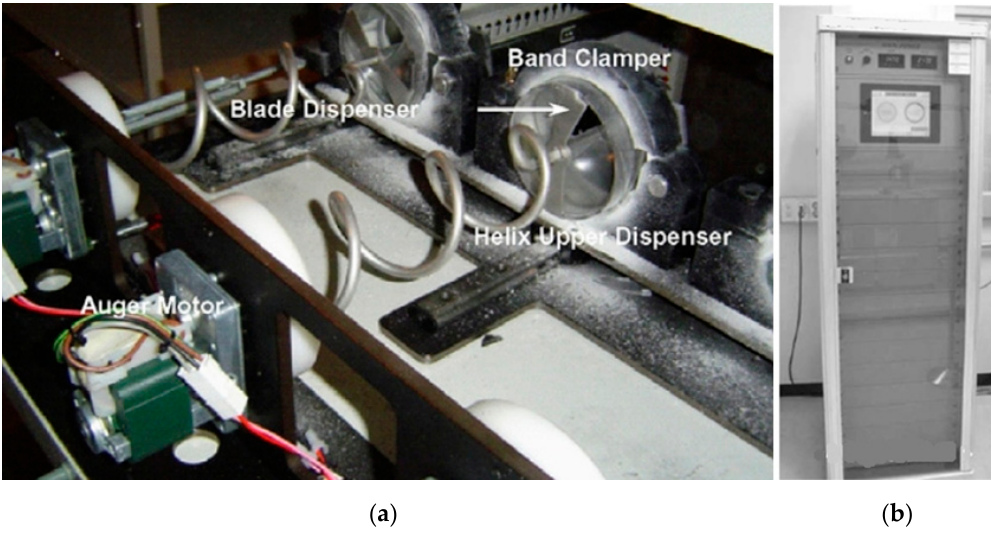
Figure 7. Equipment used in accelerated life testing and controller. ( a ) ALT Equipment; ( b ) controller.